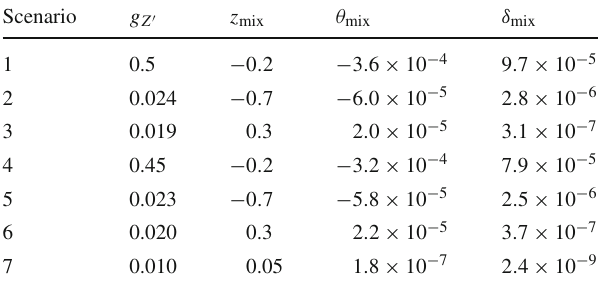
Table 15 Summary of 95% CL upper limits on Z (cid:2) coupling for m Z (cid:2) = 2 . 5 TeV (second column) and z mix factors (third column) in each scenario. The resulting Z − Z (cid:2) mixing angle and relative contri- bution to the Z boson mass are given in the fourth and fifth columns, respectively